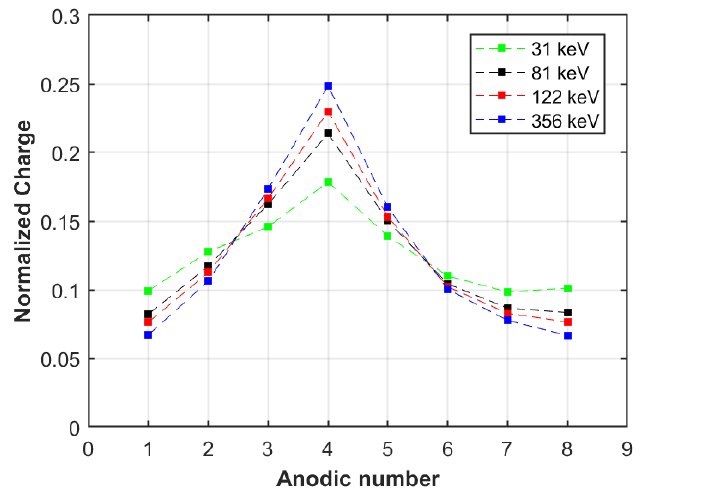
Figure 8. Projection on the X axis of the mean charge distributions for 31, 81, 122 and 356 keV corresponding to the irradiation of a central